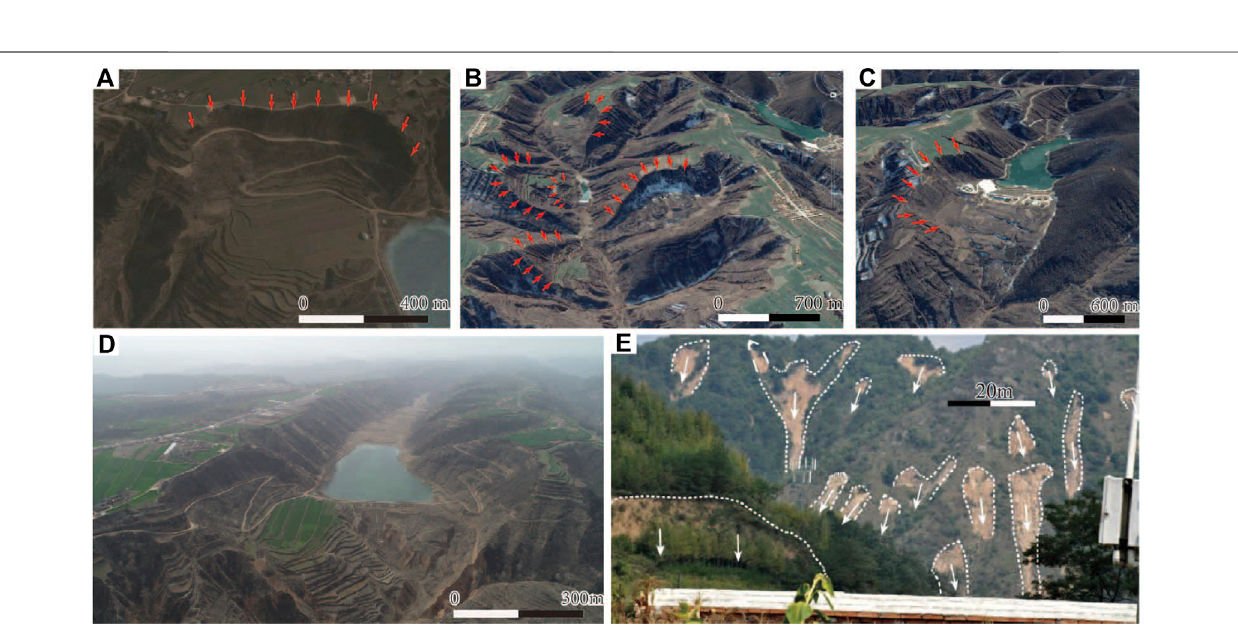
Frontiers in Earth Science |